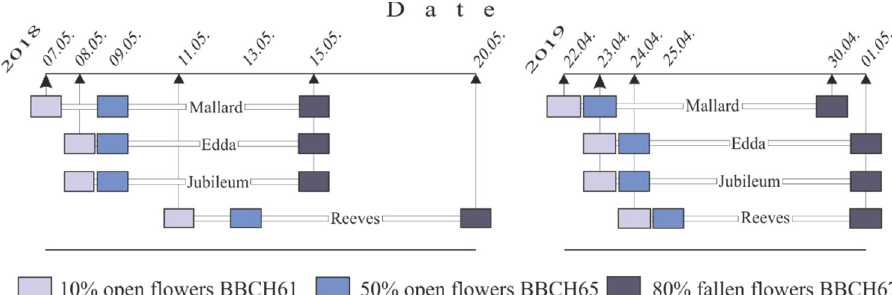
Figure 1. Flowering phenophases of plum cultivars in 2018 and 2019.